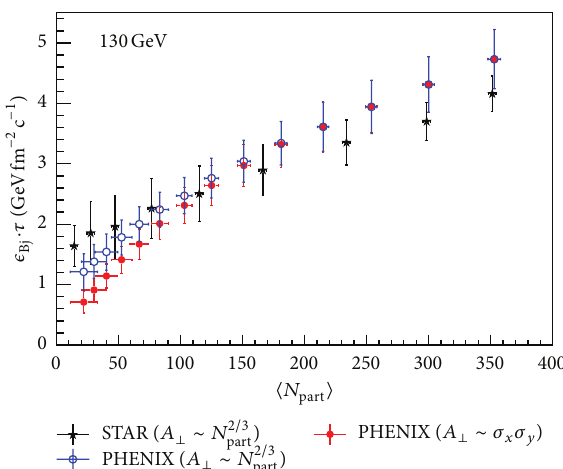
using different part = 130 GeV. The NN